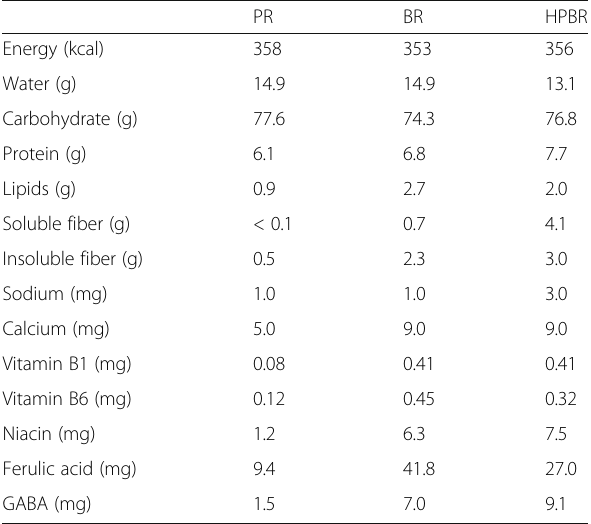
Table 1 Nutrient composition (per 100 g) in polished rice (PR), brown rice (BR) and highly water pressurized brown rice